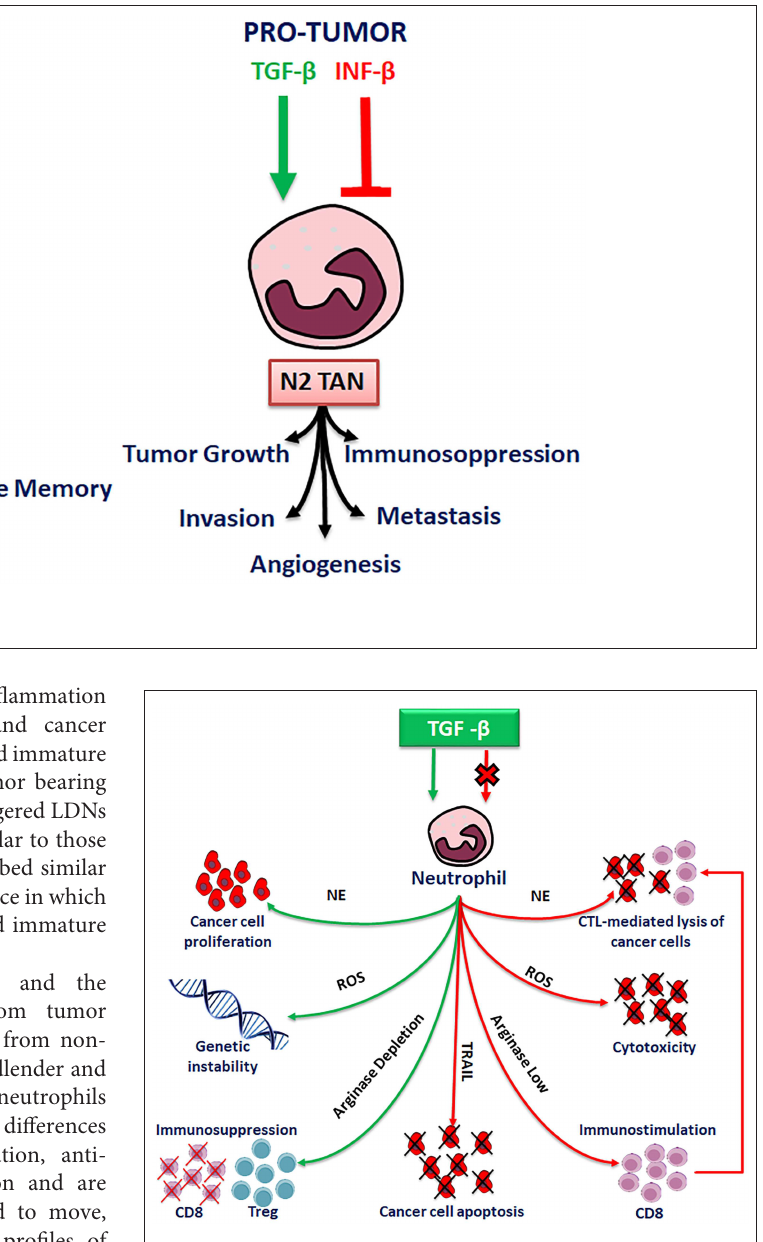
FIGURE 4 | Pro-tumor and anti-tumor functions of polarized